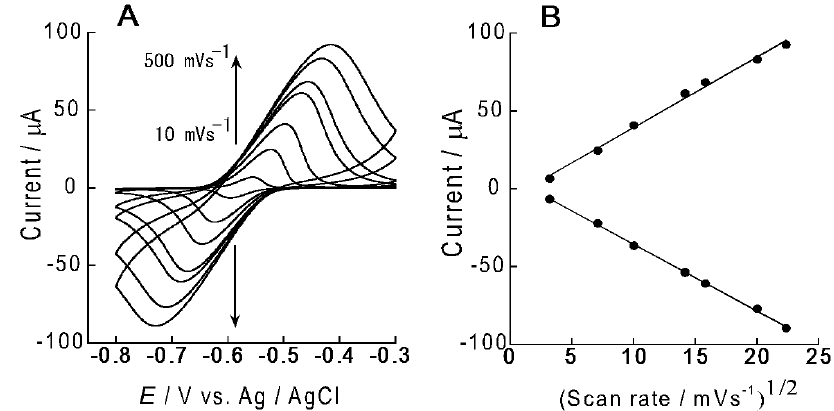
Figure 4. ( A ) The effect of scan rate on the CV of the ARS-immobilized (PEI/CMC) 10 PEI film-coated Au electrode in 10 mM HEPES buffer at pH 7.5; ( B ) Plots of redox peak currents of the CV vs. a square root of the scan rate.